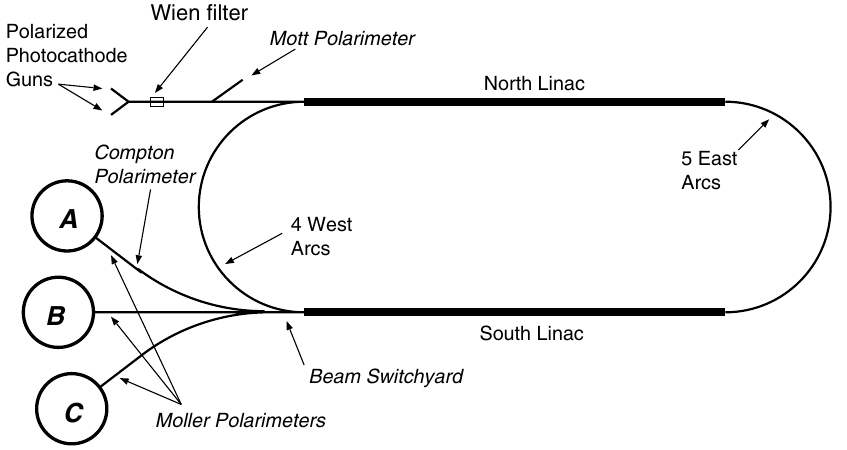
FIG. 1. Schematic of the CEBAF accelerator showing elements of the